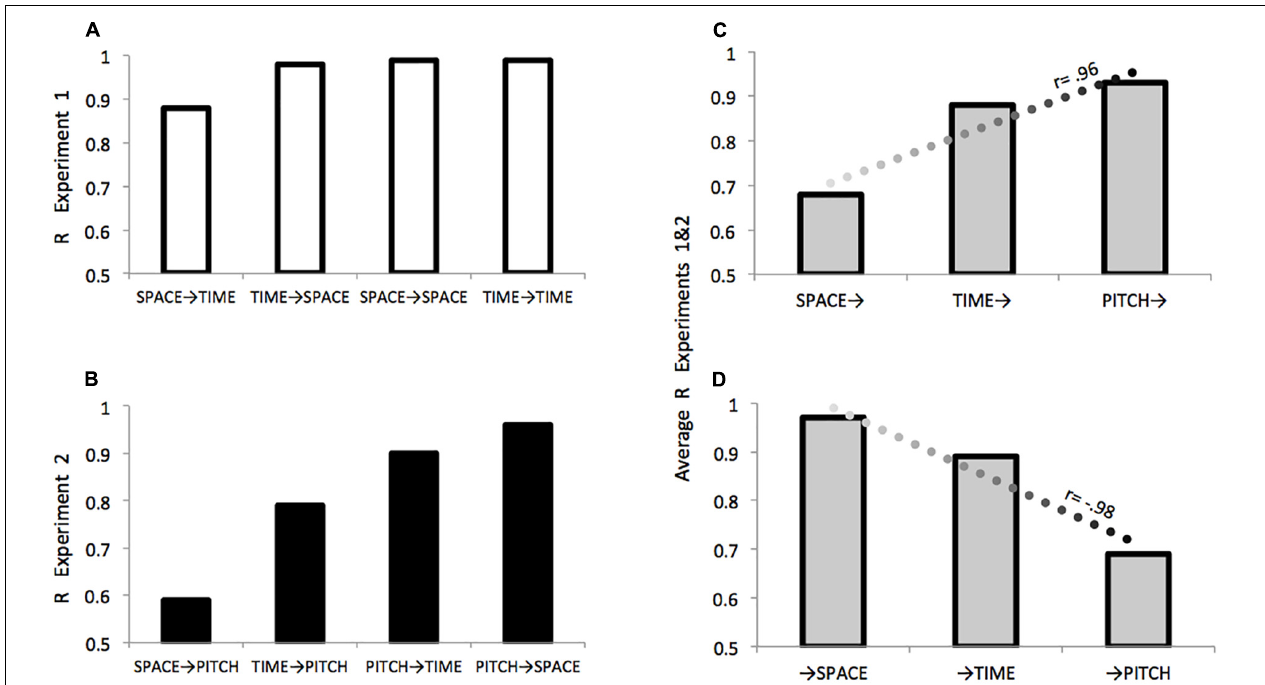
FIGURE 4 | Comparing effects within and between Experiments 1 and 2. (A) Effects of: Displacement on Duration (SPACE → TIME); Duration on Displacement (TIME → SPACE); Displacement on Displacement (SPACE → SPACE); Duration on Duration (TIME → TIME). (B) Effects of: Duration on Frequency (TIME → PITCH); Frequency on Duration (PITCH → TIME); Frequency on Displacement (PITCH → SPACE). For both Experiments 1 and 2 R values are consistent with predictions depicted in Figure 2 . For each domain across Experiments 1 and 2, (C) describes the relation between increasing relevance in the auditory modality and a particular domain’s ( X → ) effectiveness in modulating other domains as an agent of contamination, (D) describes the relation between increasing relevance in the auditory modality and the extent a particular domain ( → X ) is modulated by other domains as a patient sensitive to